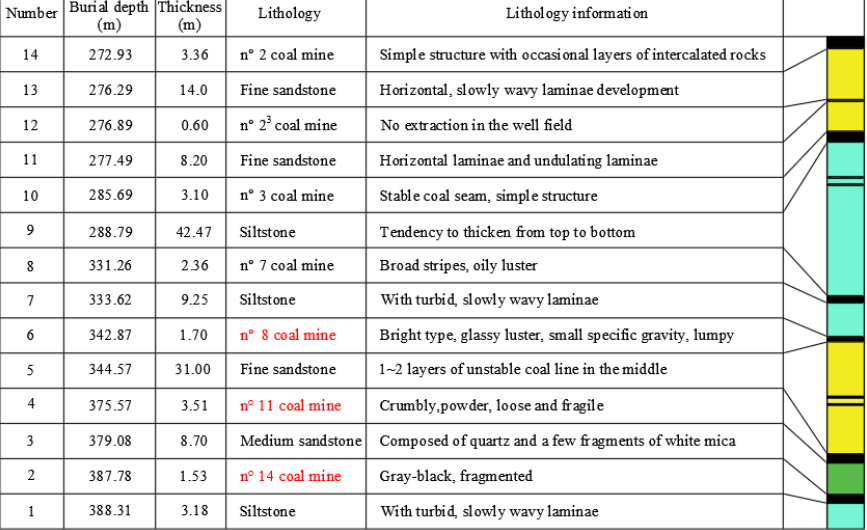
Figure 1. Coal seam histogram.